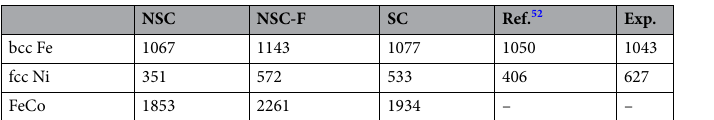
Table 1. The Curie temperatures ( T C in K) for bcc Fe, fcc Ni and B2 FeCo. All theoretical results are obtained in the mean-field approximation using exchange parameters from NSC , NSC-F and SC calculations. Note that the mean-field approximation typically overestimates the T C by ∼ 15%. The exchange parameters of Ref. 52 are obtained using the MFT approach of Liechtenstein et al. 9 in the